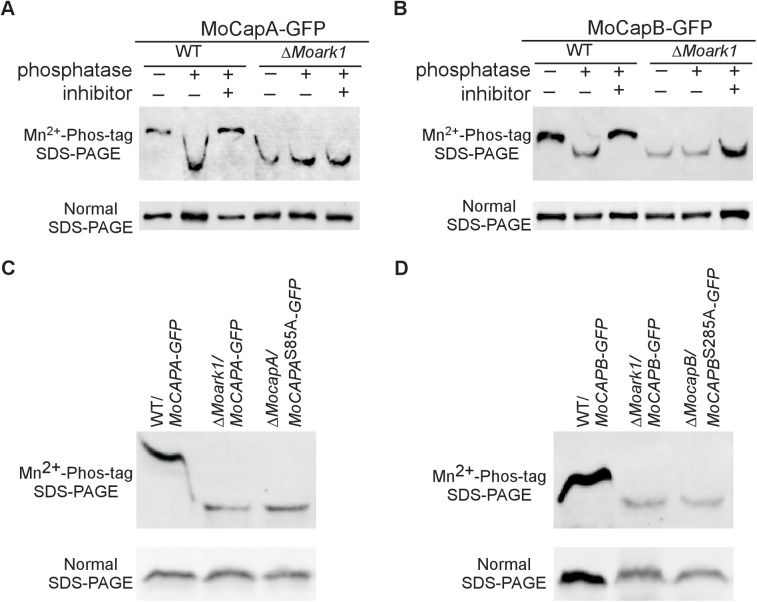
MoCapA and MoCapB are phosphorylated by MoArk1.(A and B) Green fluorescent protein-MoCapA (MoCapA-GFP) and green fluorescent protein-MoCapB (MoCapB-GFP) from wild-type and the ΔMoark1 mutant cell extracts treated with alkaline phosphatase or alkaline phosphatase and phosphatase inhibitors were subjected to Phos-tag SDS-PAGE and normal SDS-PAGE followed by immunoblotting with anti-GFP. (C and D) As MoCapA-GFP and MoCapB-GFP from wild-type and the ΔMoark1 mutant cell extracts were contrast, the phosphorylation of MoCapAS85A and MoCapBS285A was examined applying the Phos-tag SDS-PAGE method. The mobility shift of MoCapAS85A and MoCapBS285A is same to the MoCapA and MoCapB in ΔMoark1 but not the wild type.